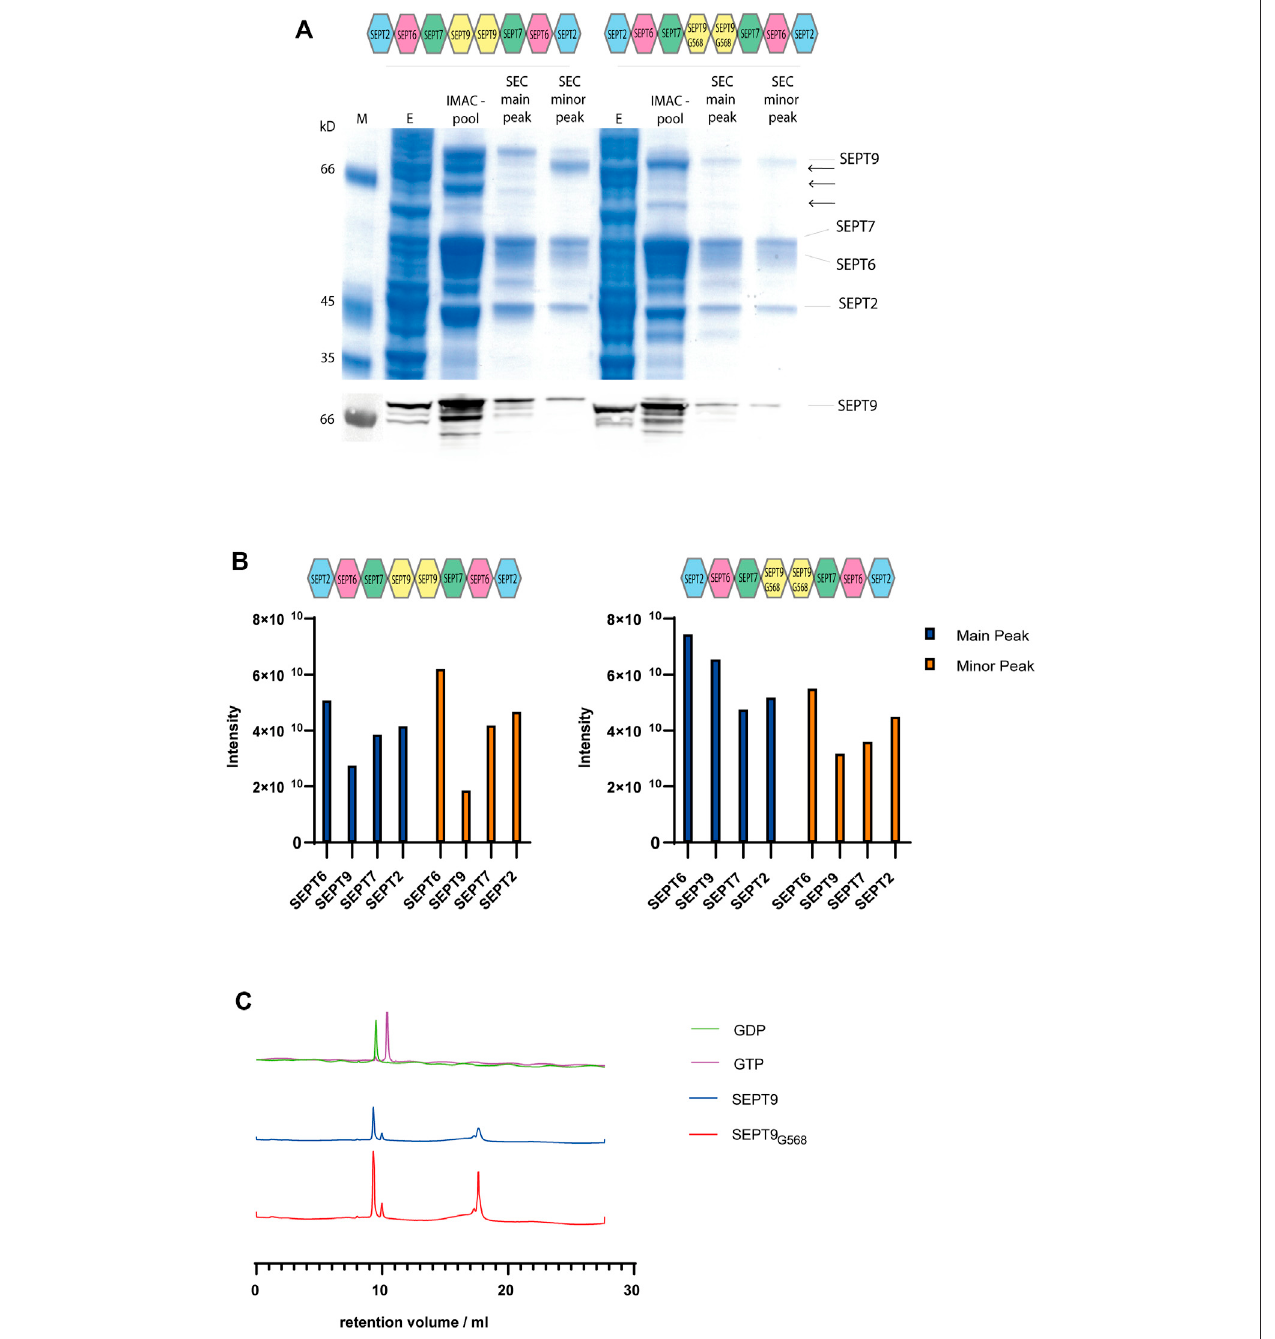
FIGURE 1 | Puri fi cation of octameric septin rods. (A) SDS-PAGE (Coomassie staining) of a representative puri fi cation of septin octamers containing SEPT9 FL and SEPT9 G568 . Fractions from IMAC and SEC including the major and minor peak are indicated. SEPT9 degradation products are marked with arrows. The anti-SEPT9 WesternblotshowstheSEPT9degradationproducts. (B) RepresentativeMSanalysisofthepuri fi edseptincomplexes.Boththemainproductpeakandtheminorpeak from SEC were analyzed. Peptide abundancies of the SEPT FL (left panel) and SEPT9 G568 (right panel) octamer are plotted; the indicated intensity score re fl ects the accumulated intensities of all peptides detected for the respective subunit. (C) Nucleotide content of octameric rods containing SEPT9 FL or SEPT9 G568 detected by analytical anion exchange chromatography (representative runs out of at least three per rod species performed) after heat denaturation of the protein. Calibration runs with GTP and GDP are shown in the upper row.